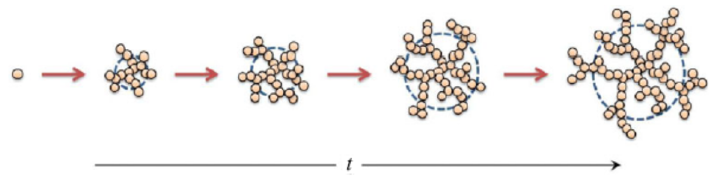
Figure 3. Pictorial description of the growth of a fractal colloidal aggregate. The mass M and the gyration radius R G of the aggregate both increase with time, and they scale as M ∼ ( R G ) D m , where D m is the mass fractal dimension of the aggregate. Picture reproduced with permission from Ref.